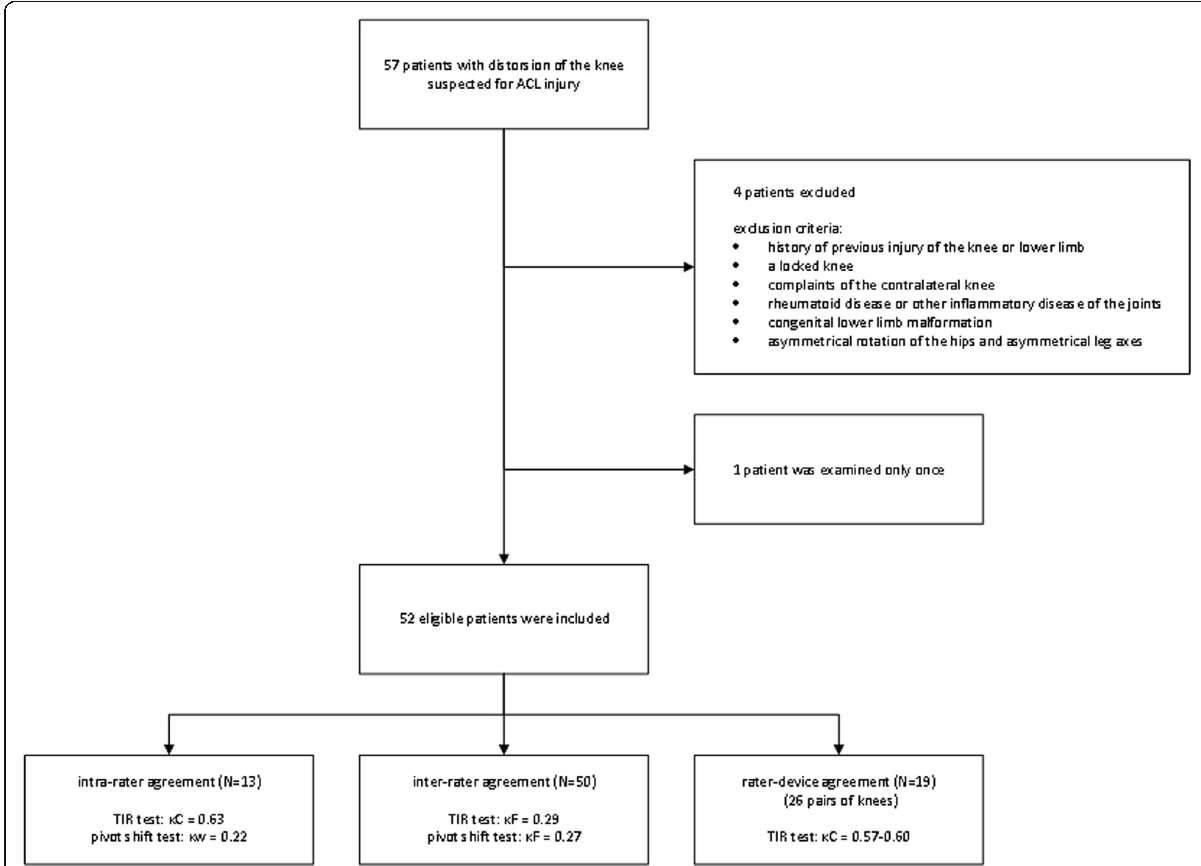
Fig. 4 Flowchart of patient selection for rater agreement reliability of the TIR test and the pivot shift